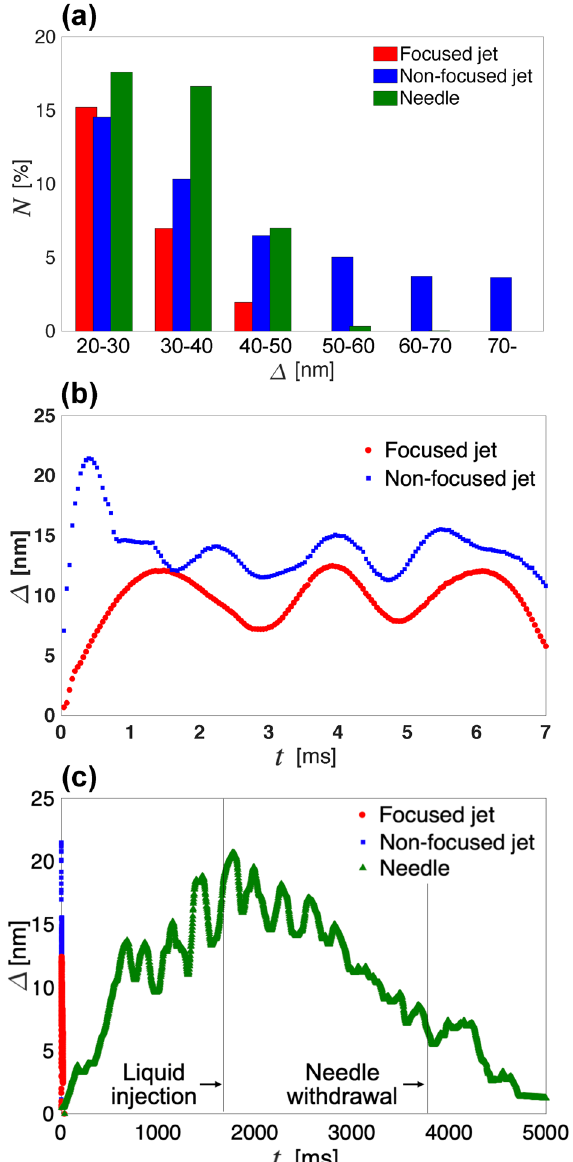
Figure 4. ( a ) Histogram of area percentage N of different ranges of phase difference ∆ in the whole image at the time of highest spatial averaged phase difference. The red, blue, and green bars show the result of the focused jet, non-focused jet, and needle respectively. ( b – c ) Spatial averaged stress versus time t for comparison between (b) the focused and non-focused microjets, ( c ) the microjets and the needle penetration. The red, blue, and green plots show the spatial averaged stress of the focused microjet, the non-focused microjet, and needle injection,